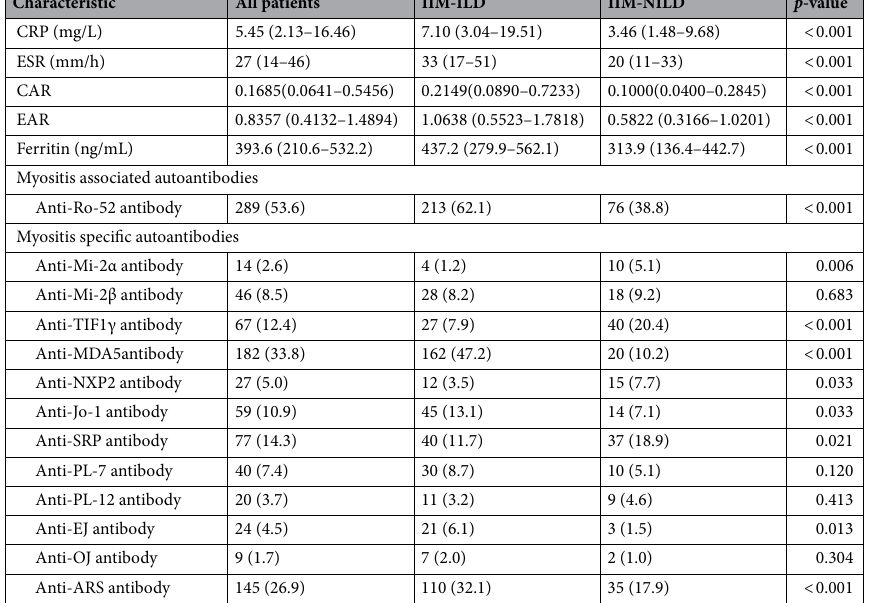
Table 1. Comparison of clinical characteristics between IIM-ILD group and IIM-NILD group. Values are presented as number (%) or median (range). IIM-ILD, idiopathic inflammatory myopathy patients with interstitial lung disease; IIM-NILD, idiopathic inflammatory myopathy patients without interstitial lung disease; ESR, erythrocyte sedimentation rate; CRP, C-reactive protein; NLR, neutrophil-to-lymphocyte ratio; PLR, platelet-lymphocyte ratio; CAR, the C-reactive protein to Albumin ratio; EAR, the erythrocyte sedimentation rate to Albumin ratio; ARS, aminoacyl-tRNA synthetase.